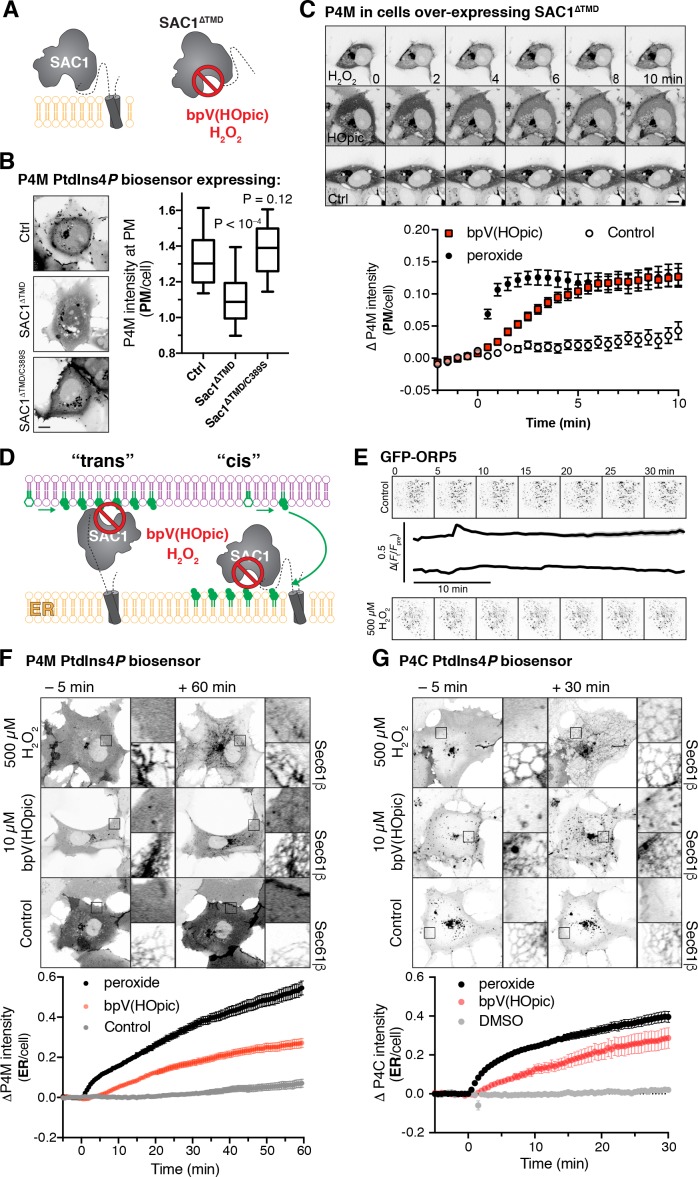
Inhibition of SAC1 causes PtdIns4P accumulation in the ER.(A) A soluble fragment of SAC1 (SAC1∆TMD) is inhibited by peroxide and bpV(HOpic). (B) SAC1 expression depletes PM PtdIns4P. COS-7 cells transfected with GFP-P4M and either FKBP-mCherry (Ctrl), SAC1∆TMD-FKBP-mCherry or catalytically inactive SAC1∆TMD/C389S-FKBP-mCherry were imaged live by confocal microscopy. Representative images are shown (bar = 10 µm). The graph shows P4M intensity at the plasma membrane (defined by CellMask deep red dye) normalized to total cell intensity; box and whisker plot shows quartiles and 5–95 percentiles of 90 cells from three independent experiments. P values derive from Dunn’s multiple comparison test compared to Ctrl after a Kruskal-Wallis test (p<10–4). (C) Peroxide and bpV(HOpic) inhibit SAC1 in live cells. COS-7 cells were transfected with P4M and SAC1∆TMD as in B and imaged by time-lapse confocal microscopy. 500 µM peroxide or 10 µM bpV(HOpic) were added at time 0. P4M intensity was quantified as in B. Data are means ± s.e. of 44 or 45 cells from four independent experiments. Scale bar = 10 µm. (D) Predicted PtdIns4P accumulation for ‘cis’ and ‘trans’ operation of SAC1. (E) Peroxide does not disrupt ORP5 localization at ER-PM MCS. Images show TIRF images of COS-7 cells expressing GFP-ORP5 at the indicated times. Traces are means with s.e. shaded for 31–32 cells from three independent experiments. (F–G) SAC1 inhibitors cause PtdIns4P accumulation in the ER. Time-lapse images of representative COS-7 cells expressing GFP-P4M (F) or GFP-P4C (G) and treated with inhibitors at time 0. The insets are 10 µm squares, and are expanded at right and show PtdIns4P accumulation relative to a co-expressed ER marker, iRFP-Sec61β. Graphs show P4M intensity at the ER (defined by iRFP-Sec61β) normalized to total cell intensity; data are means ± s.e. of 38–41 (F) or 29–30 (G) cells from three (G) or four (F) independent experiments.10.7554/eLife.35588.003Figure 1—source data 1.Data for panel 1B.10.7554/eLife.35588.004Figure 1—source data 2.Data for panel 1C.10.7554/eLife.35588.005Figure 1—source data 3.Data for panel 1E.10.7554/eLife.35588.006Figure 1—source data 4.Data for panel 1F.10.7554/eLife.35588.007Figure 1—source data 5.Data for panel 1G.